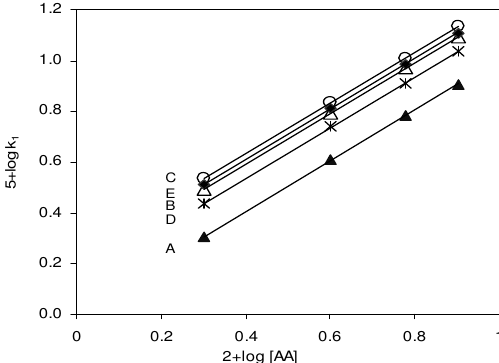
(A=Glycine; B=Alanine; C=Histidine; 1